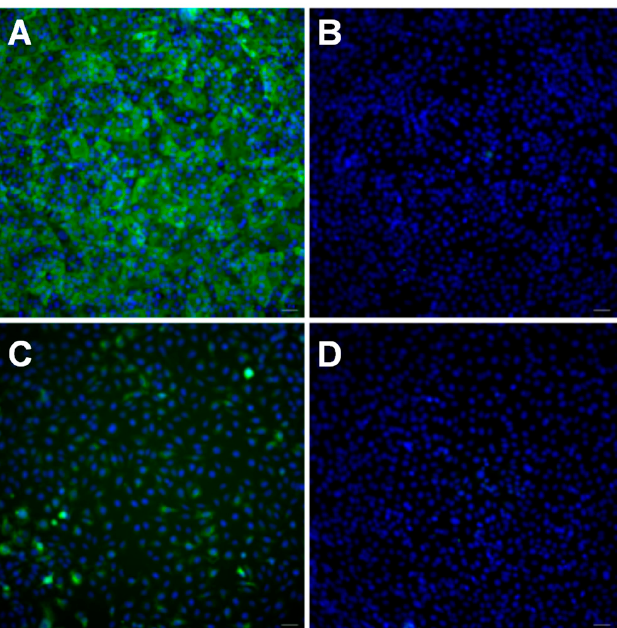
Figure 7. The immunostaining of P-gp on ( A ) iBECs labeled with P-gp antibody Alexa-488 tagged secondary antibody; ( B ) iBECs labeled only with Alexa-488 tagged secondary antibody; ( C ) MDA- Mb-231 Br labeled with P-gp antibody Alexa-488 tagged secondary antibody; and ( D ) MDA-Mb-231 Br labeled only with Alexa-488 tagged secondary antibody. Cells were observed using a 20 × objective. Cell nuclei were stained with DAPI blue.